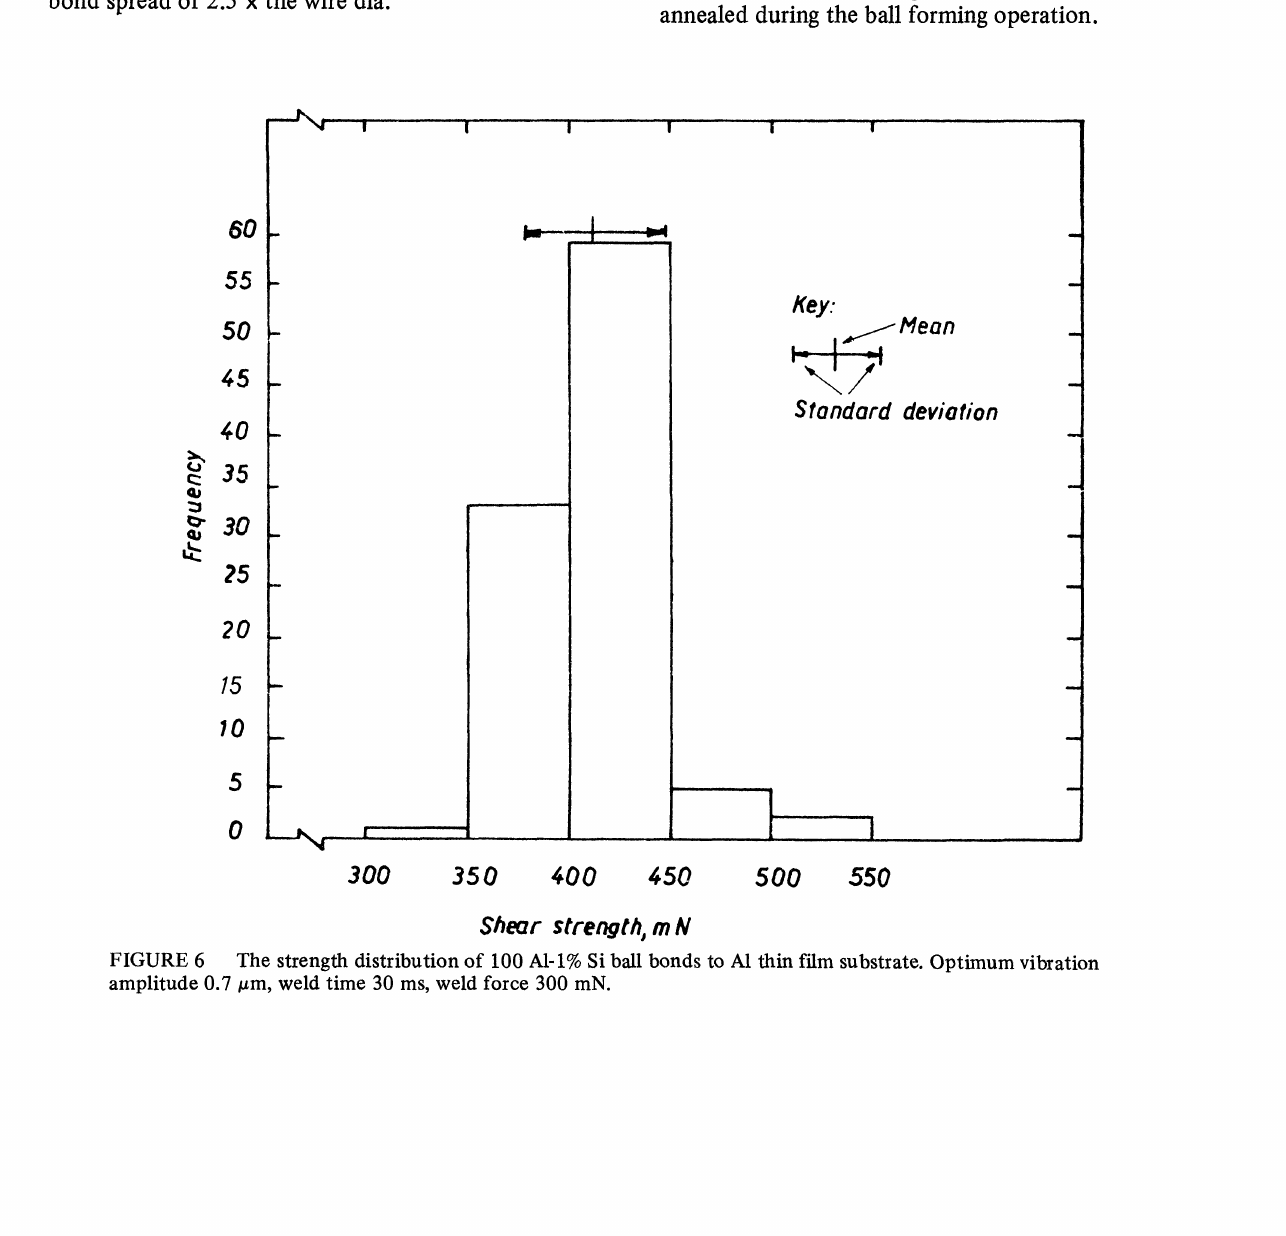
The strength distribution of 100 A1-1% Si ball bonds to At thin film substrate. Optimum vibration amplitude 0.7 m, weld time 30 ms, weld force 300